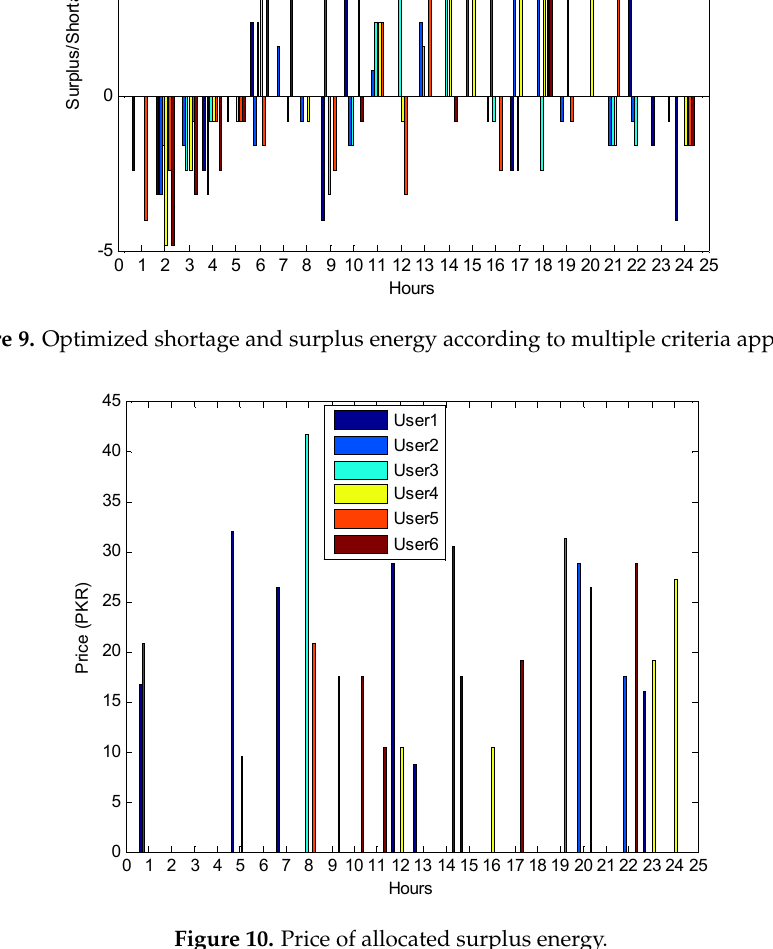
Table 2. Effect of weight ‘ w ’ on optimization results.